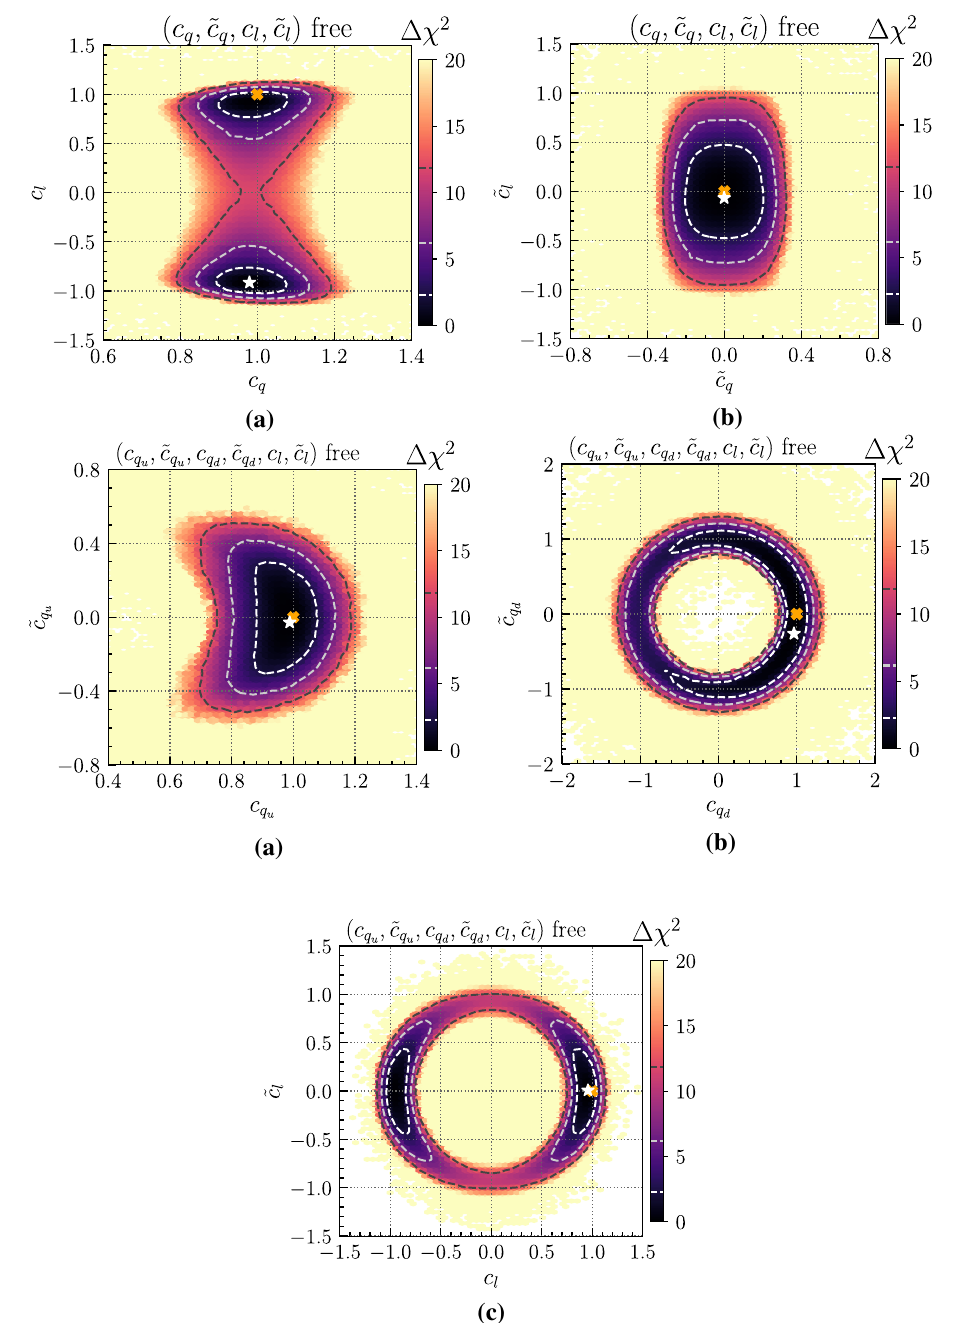
again dominated by the constraints on the third generation couplings and only weakly correlated: the constraints on c q u and ˜ c q , see Fig. 16a, resemble the ( c t , ˜ c t ) fit shown in Fig. 3a u with the bounds being slightly looser due to the additional variation of the bottom-Yukawa coupling; the constraints on c q and ˜ c q , see Fig. 16b, resemble the ( c b , ˜ c b ) fit shown in d d Fig. 3b with the bounds being slightly looser due to the addi- tional variation of the top-Yukawa coupling; the constraints on c l and ˜ c l , see Fig. 16c, resemble the ( c l , ˜ c l ) fit shown in = Fig. 6a. The best-fit point is found at χ 2 min